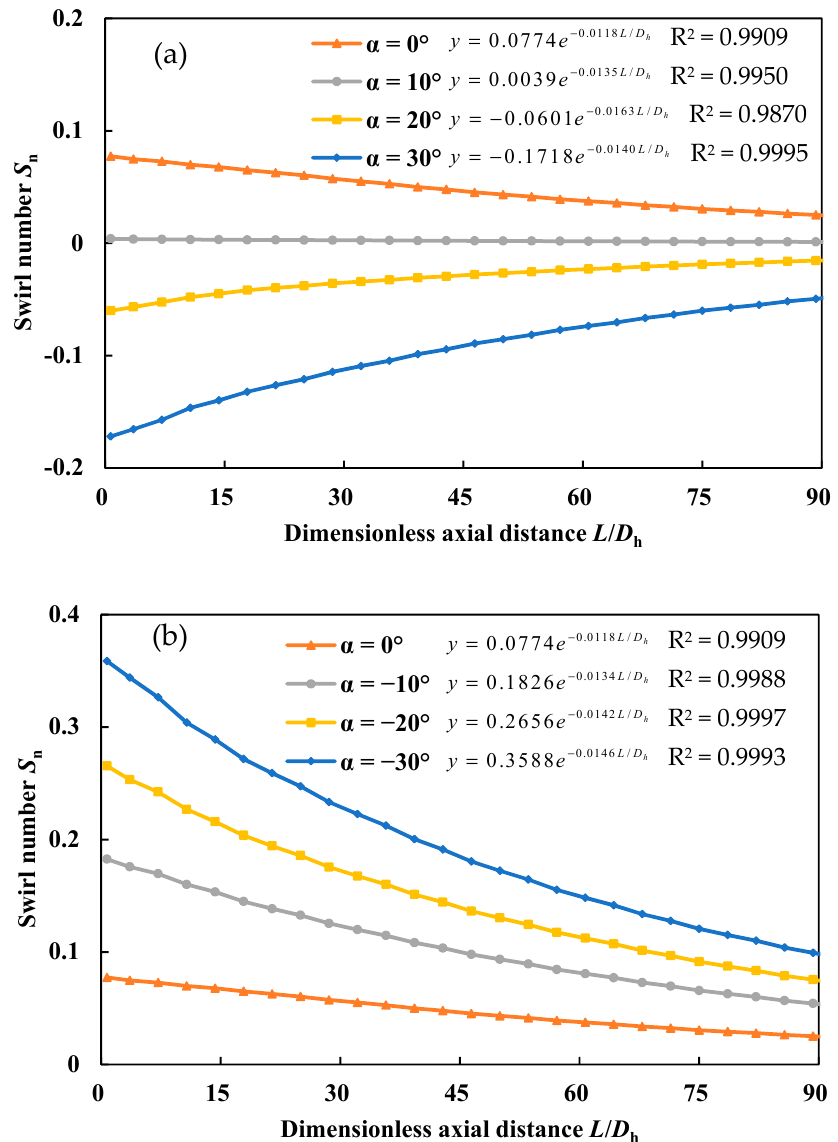
Figure 8. Variation curve of swirl number along the flow direction for the straight blade with different helical angles at 120 rpm: ( a ) positive blade and ( b ) negative blade.